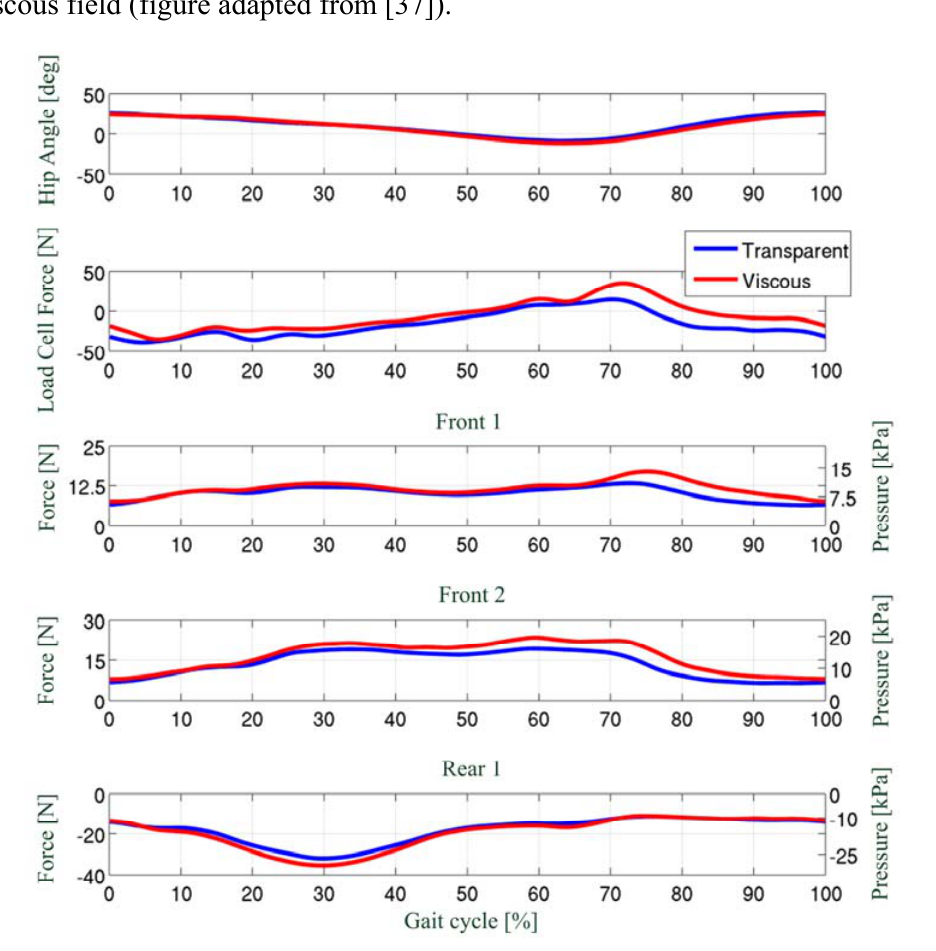
Figure 13. Test of PSP1.1 on the LOPES: profiles of right hip flexion-extension angle, total interaction force measured by the load cell, and the force estimated by three of the six PSPs ( i.e. , “Front 1”, “Front 2”, “Rear 1”). Data are shown for two conditions: transparent and viscous field (figure adapted from